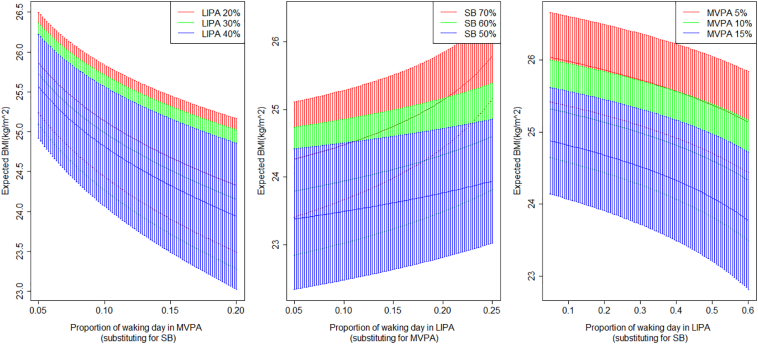
Expected BMI (and 95% confidence intervals) predicted based on the balance of SB and MVPA against different compositions of physical activity in the waking day shown as functions of MVPA substituted for SB depending on different time spent in LIPA, LIPA substituted for MVPA, and LIPA substituted for SB. Based on Health Survey for England 2008.